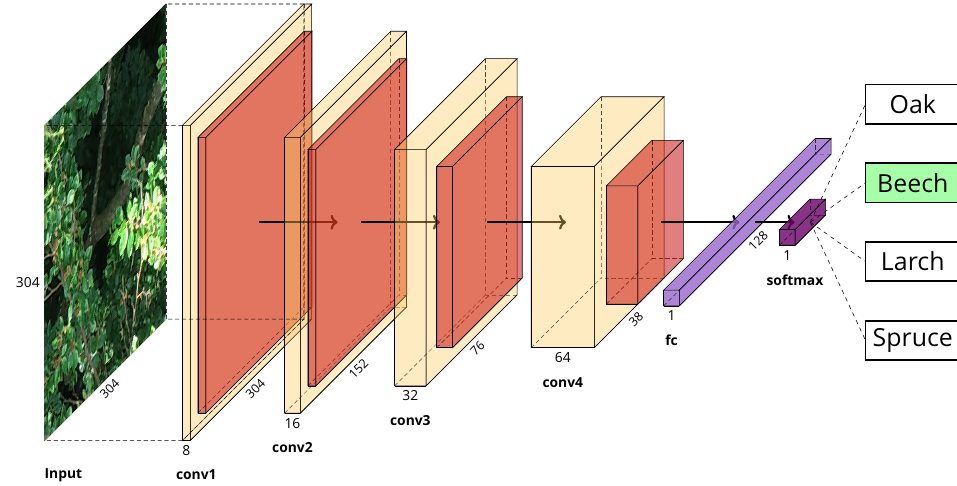
Figure 4. Model architecture of the CNN used in this study. The model consists of four consecutive convolution/pooling blocks (conv1 to conv4), one fully connected layer (fc) and a final output layer with four classes that can be mapped to the four tree species considered in this study. (Plot generated with the PlotNeuralNetwork software by Iqbal